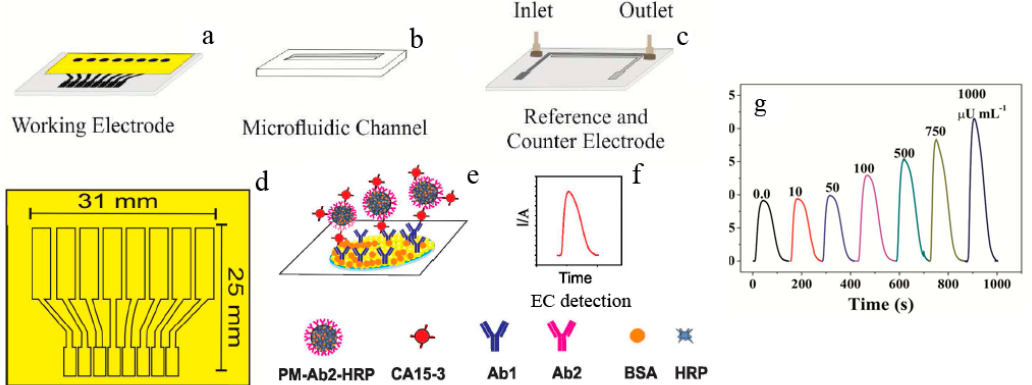
Figure 4. Construction of a disposable microfluidic immunoarray device: ( a ) working electrode; ( b ) microfluidic channel and ( c ) reference and counter electrodes; ( d ) pattern and size of the working electrode array; ( e ) the formation of the immunosandwich structure; ( f ) EC detection strategy; ( g ) amperometric responses of CA15–3 standard solutions at − 0.2 V vs. Ag/AgCl after the injection of a mixture of H 2 O 2 and HQ. Reproduced from [23] with permission from the American Chemical Society.